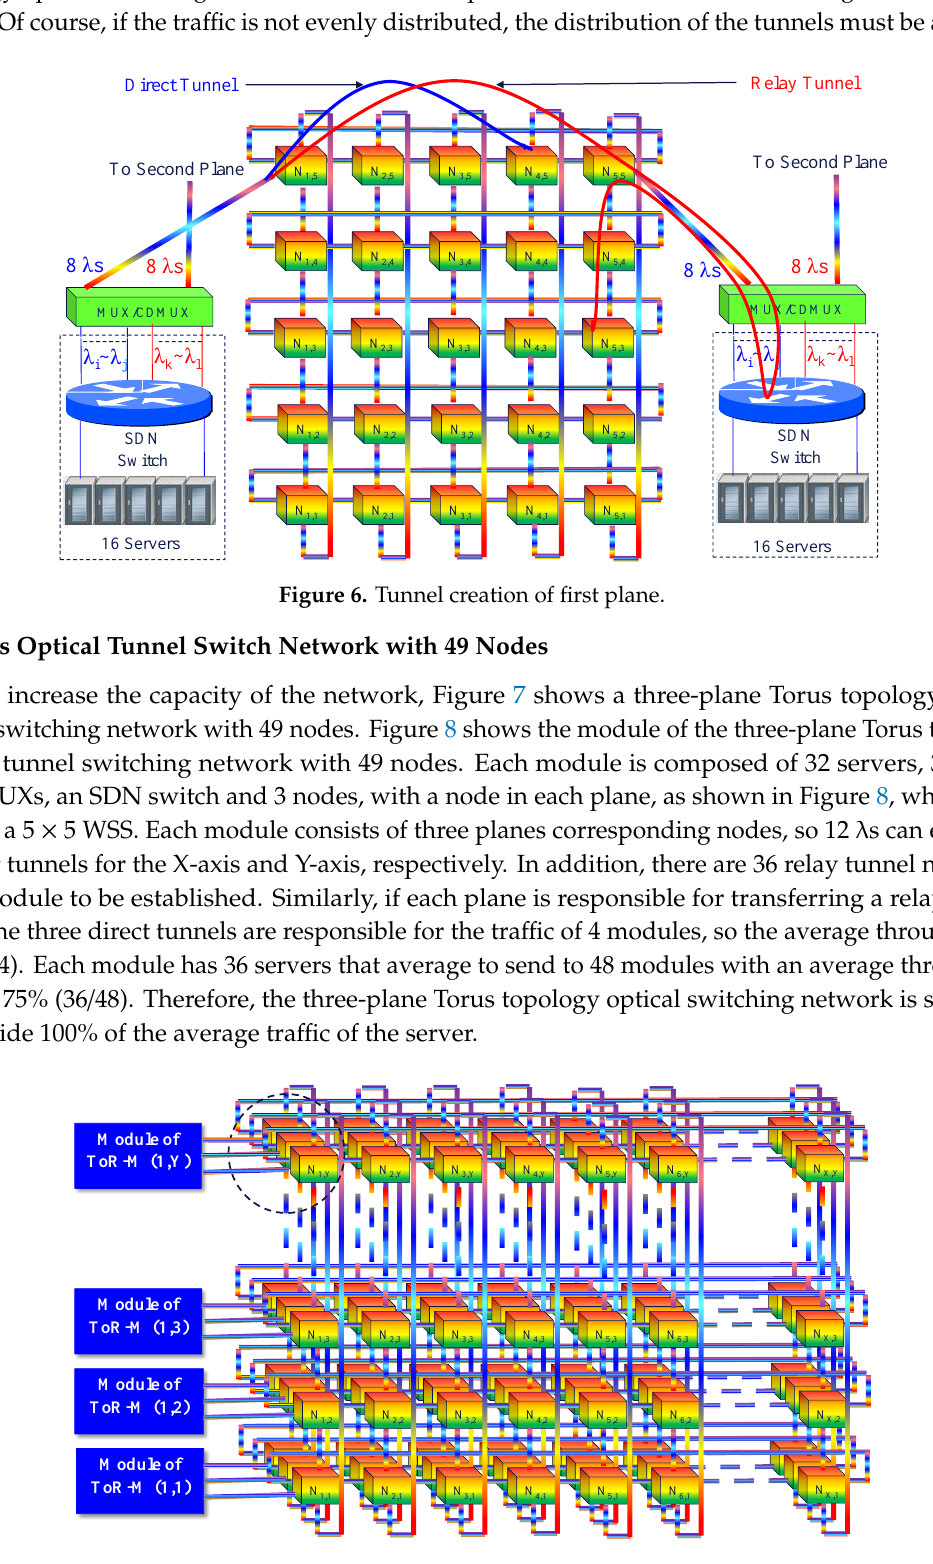
Figure 8. A module of Three-plane Torus topology optical tunnel switching network. Figure 9. Tunnel creation of first plane. Figure 9 shows tunnel creation of a three-plane Torus topology optical tunnel switching network with 49 nodes for the first plane. Let X = Y = 7. Therefore, node N (1, 7) and node N (6, 7) can establish a direct tunnel, and node N (1, 7) and node N (7, 2) need to establish a relay tunnel through node N (7, 7). Similarly, node N (1, 3) and node N (7, 3) can establish a direct tunnel, and node N (1, 3) and node N (6, 1) need to establish a relay tunnel through node N (6, 3). Other nodes can also establish direct tunnels and relay tunnels in sequence.